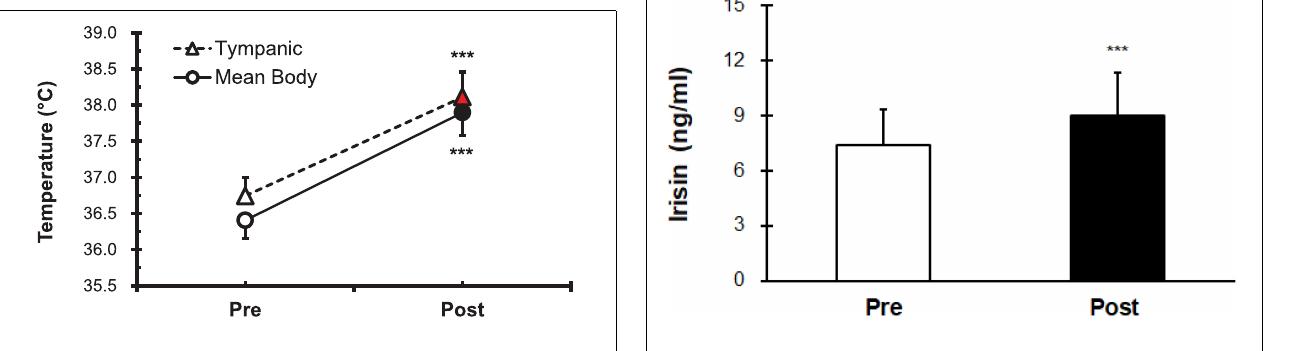
FIGURE 2 | Comparison of serum irisin concentration before (Pre) and after (Post) hot water bath (42 ± 0.5 ◦ C) immersion. Values are mean ± SD. *** P < 0.001, statistically significant difference between Pre- and Post-exposure